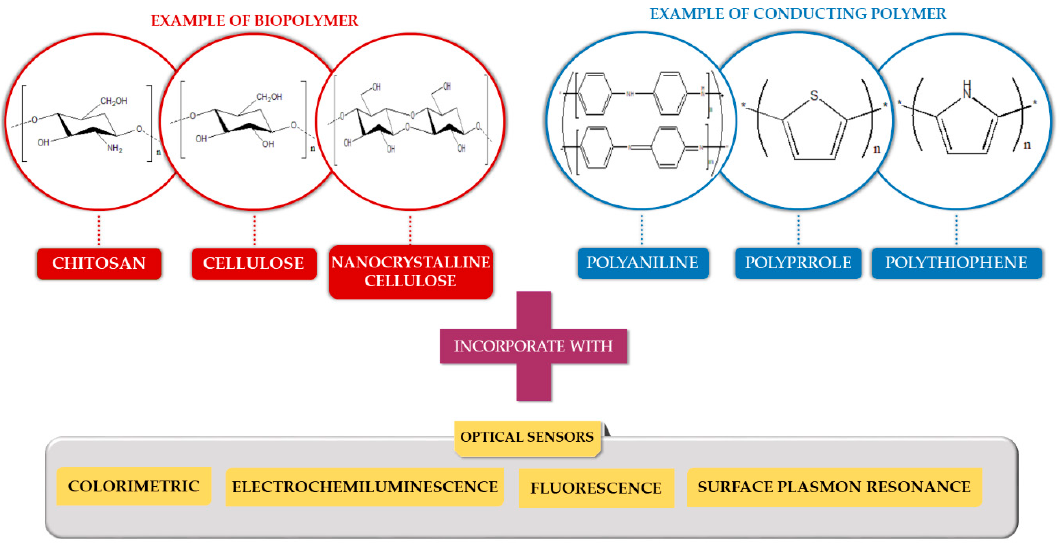
Figure 2. Illustration of biopolymers and conducting polymers incorporated with various types of optical sensors.